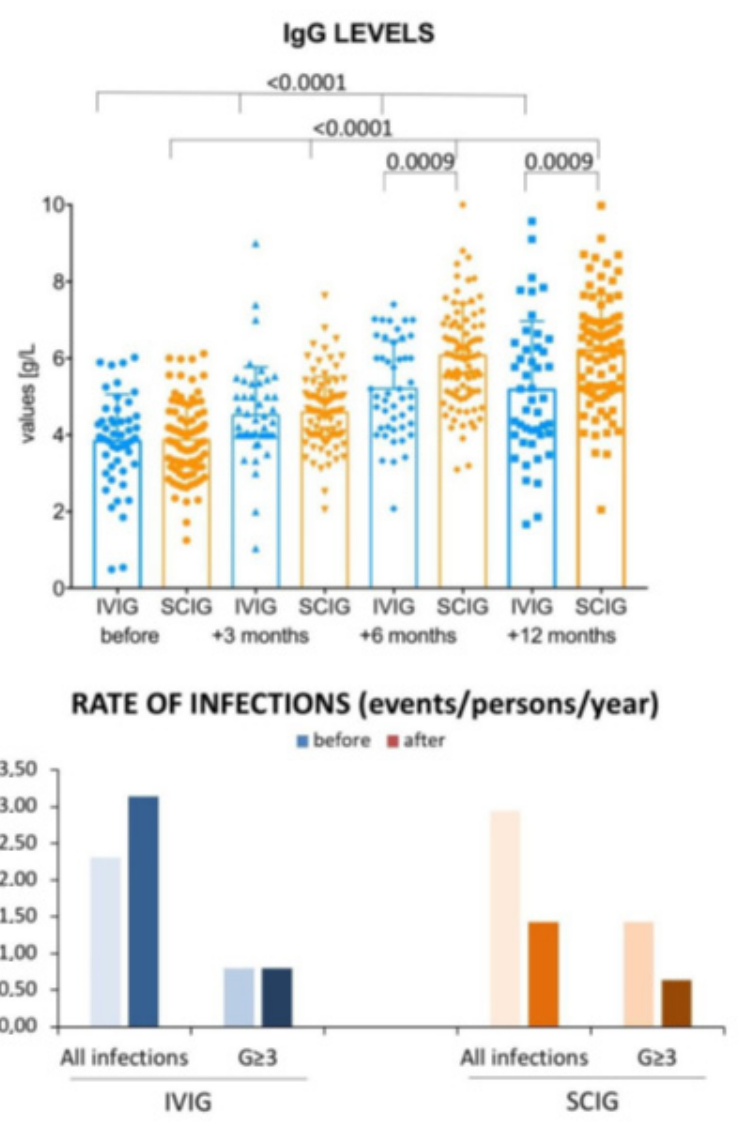
Figure 1. Histograms of IgG levels and infection rates. In the upper panel ( A ) there is a histogram reporting the serum IgG levels at baseline, after 3, 6 and 12 months of intravenous immunoglobulins (IVIG) or subcutaneous immunoglobulin (SCIG). Kruskal–Wallis test was used to analyse IgG levels in patients receiving IVIG and SCIG at different time points. Mann–Whitney test was used to compare IgG at same time point between patients receiving IVIG and SCIG. SCIG allowed patients to reach higher IgG trough levels than IVIG after at least 6 months of treatment. In particular, at month +6, IgG > 6 g/L was achieved by 33.2% and 52.3% of patients with IVIG and SCIG ( p = 0.0322), respectively. In the lower panel ( B ) are shown the rates, expressed as events/person/year, of all infections and grade ≥ 3 (G3) events before and after IVIG and SCIG.